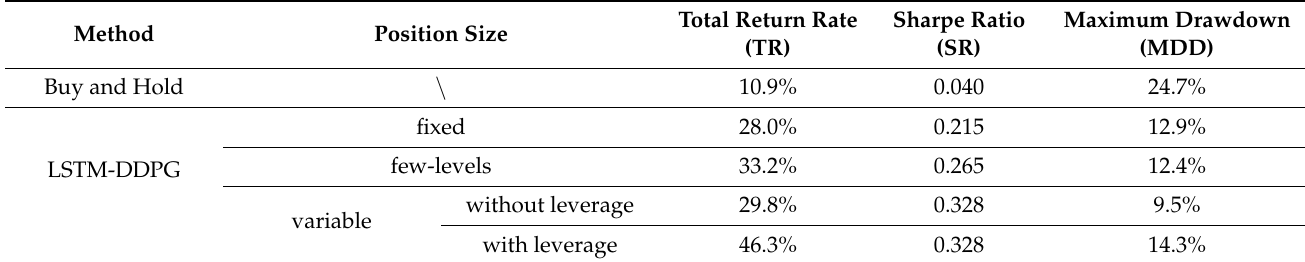
Table 3. Performance of buy and hold, LSTM-DDPG with fixed, few-levels and variable position sizes.